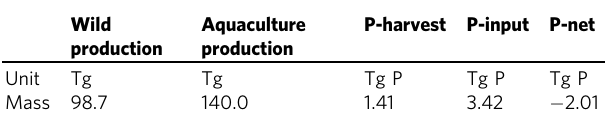
Table 1 Projections of mean global fi shery P budget in